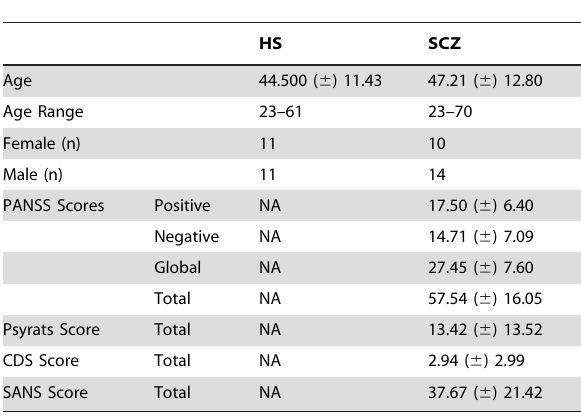
Table 1. Demographic Data for Healthy Subjects (HS) and patients with schizophrenia (SCZ) and the assessment of psychotic symptoms in patients with SCZ rTMS ( 6 ) 1 standard